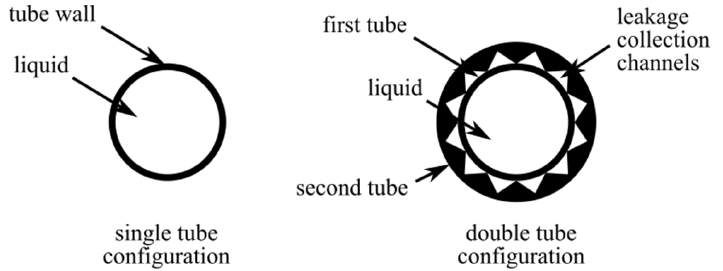
Figure 27. Double tube configuration [87].